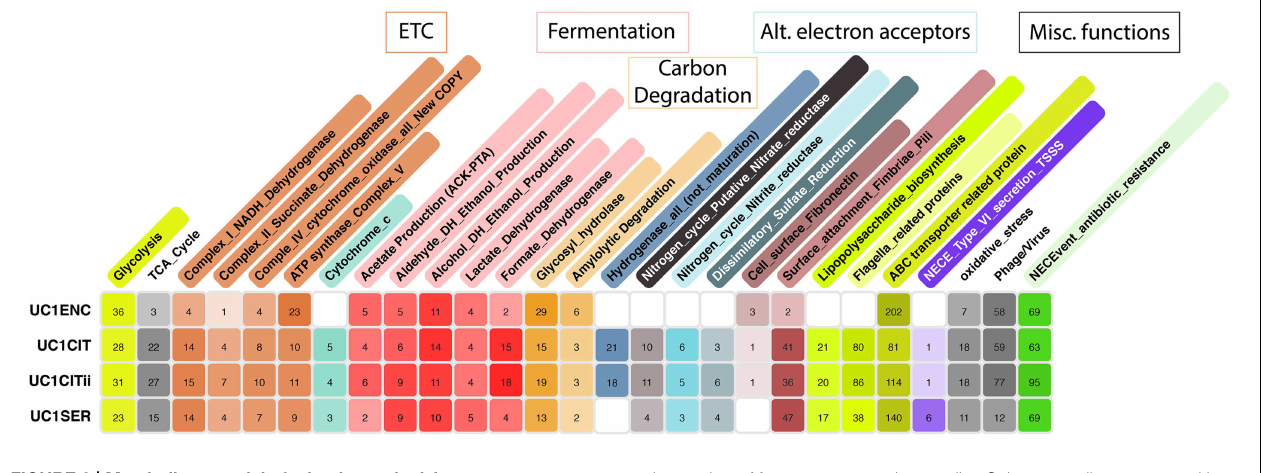
FIGURE 2 | Metabolic potential of microbes colonizing a preterm infant gut. ggKbase lists illustrate the broad metabolic potential of microbes colonizing a preterm infant in the first month of life. Numbers in each cell are